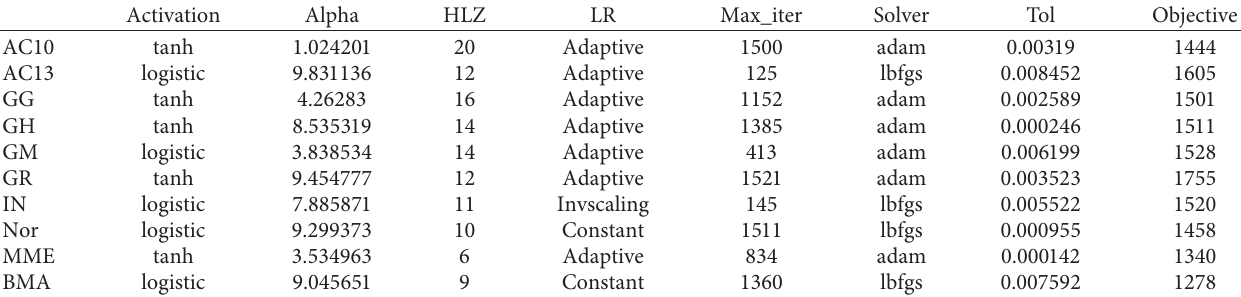
Table 8: Optimal results of Bayesian hyperparameter optimization for MLP for region mean.